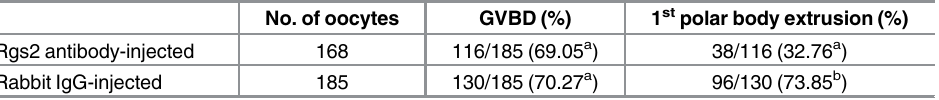
Table 1. Effects of antibody-mediated inhibition of the binding of RGS2 and β -tubulin on GVBD and first polar body extrusion oocyte maturation. No. of oocytes GVBD (%) 1 st polar body extrusion (%) Rgs2 antibody-injected 168 Rabbit IgG-injected 185 Note: ab, values with different superscript characters within each column indicate a statistically signi fi cant difference (P < 0.05). Data were analyzed using the χ 2 test. GVBD, germinal vesicle breakdown.